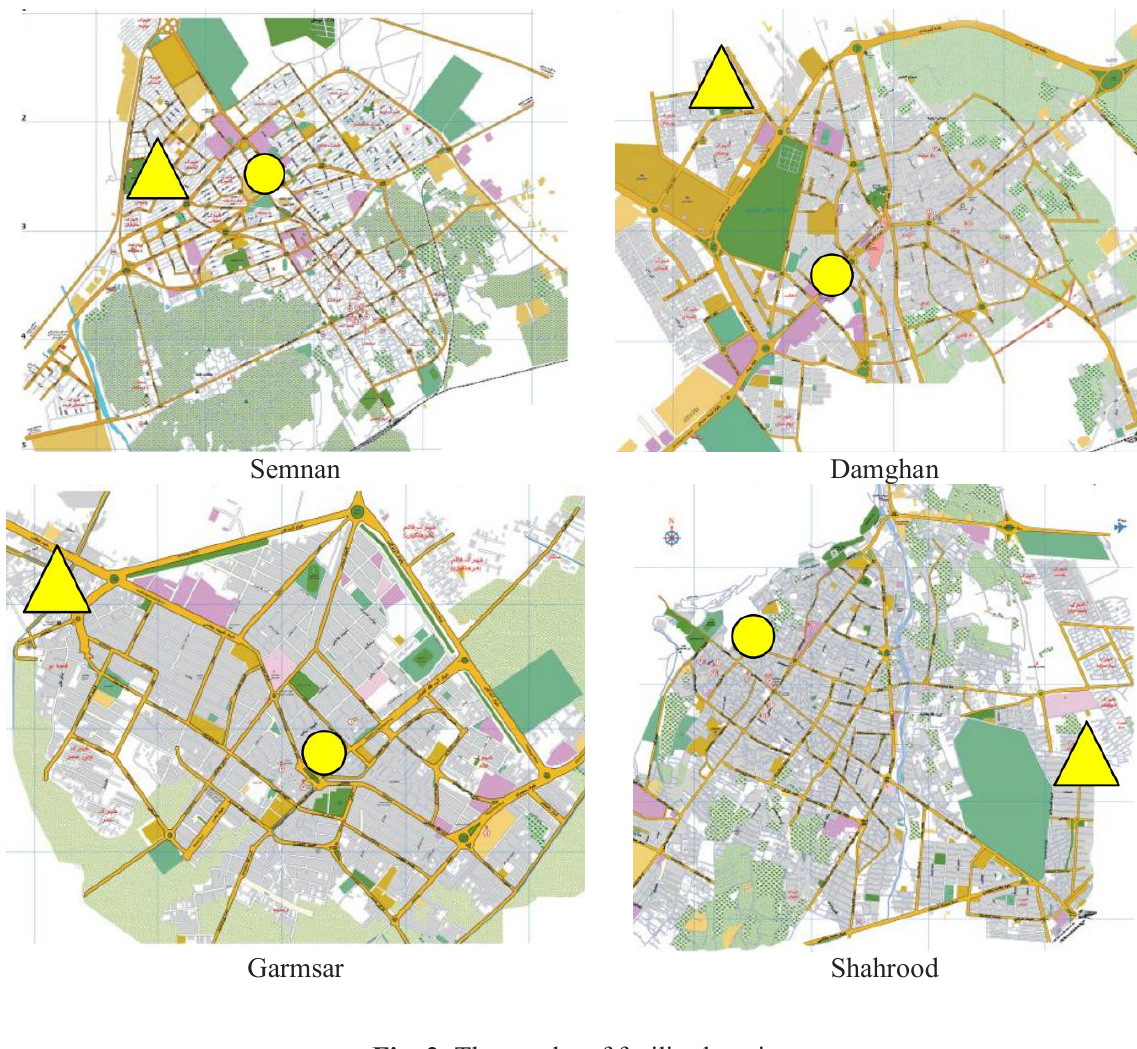
Fig. 2. The results of facility